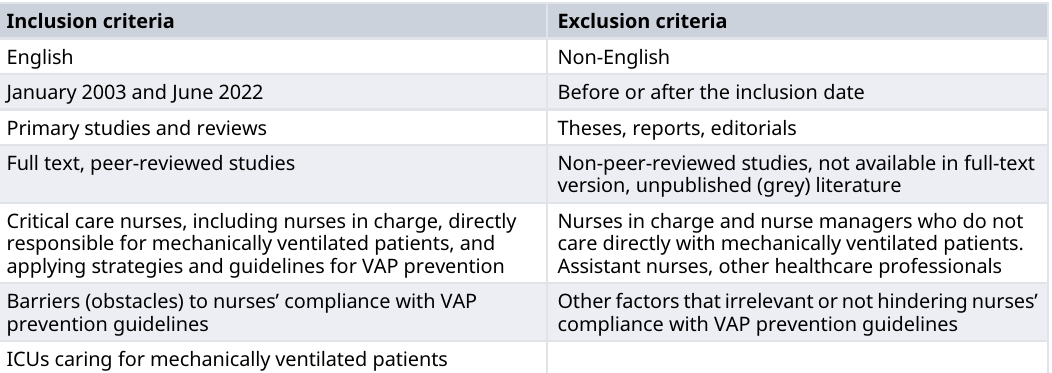
Table 1. Inclusion and exclusion criteria for selected